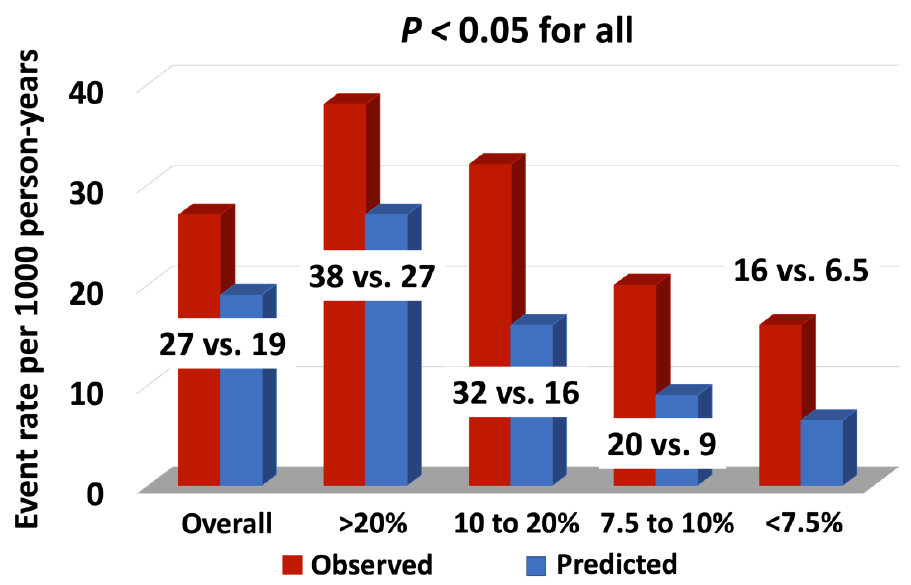
Figure 5. Current standard clinical calculators used for statin eligibility determination underestimate the risk for an ASCVD event. The bars represent predicted risk for an ASCVD event overall and in groups separated by <7.5% to over 20%. The red bars on the left represent observed risk for an ASCVD event overall and in groups separated by <7.5% to over 20%. The blue bars represent the average predicted risk in the group. ASCVD = Atherosclerotic Cardiovascular Disease.